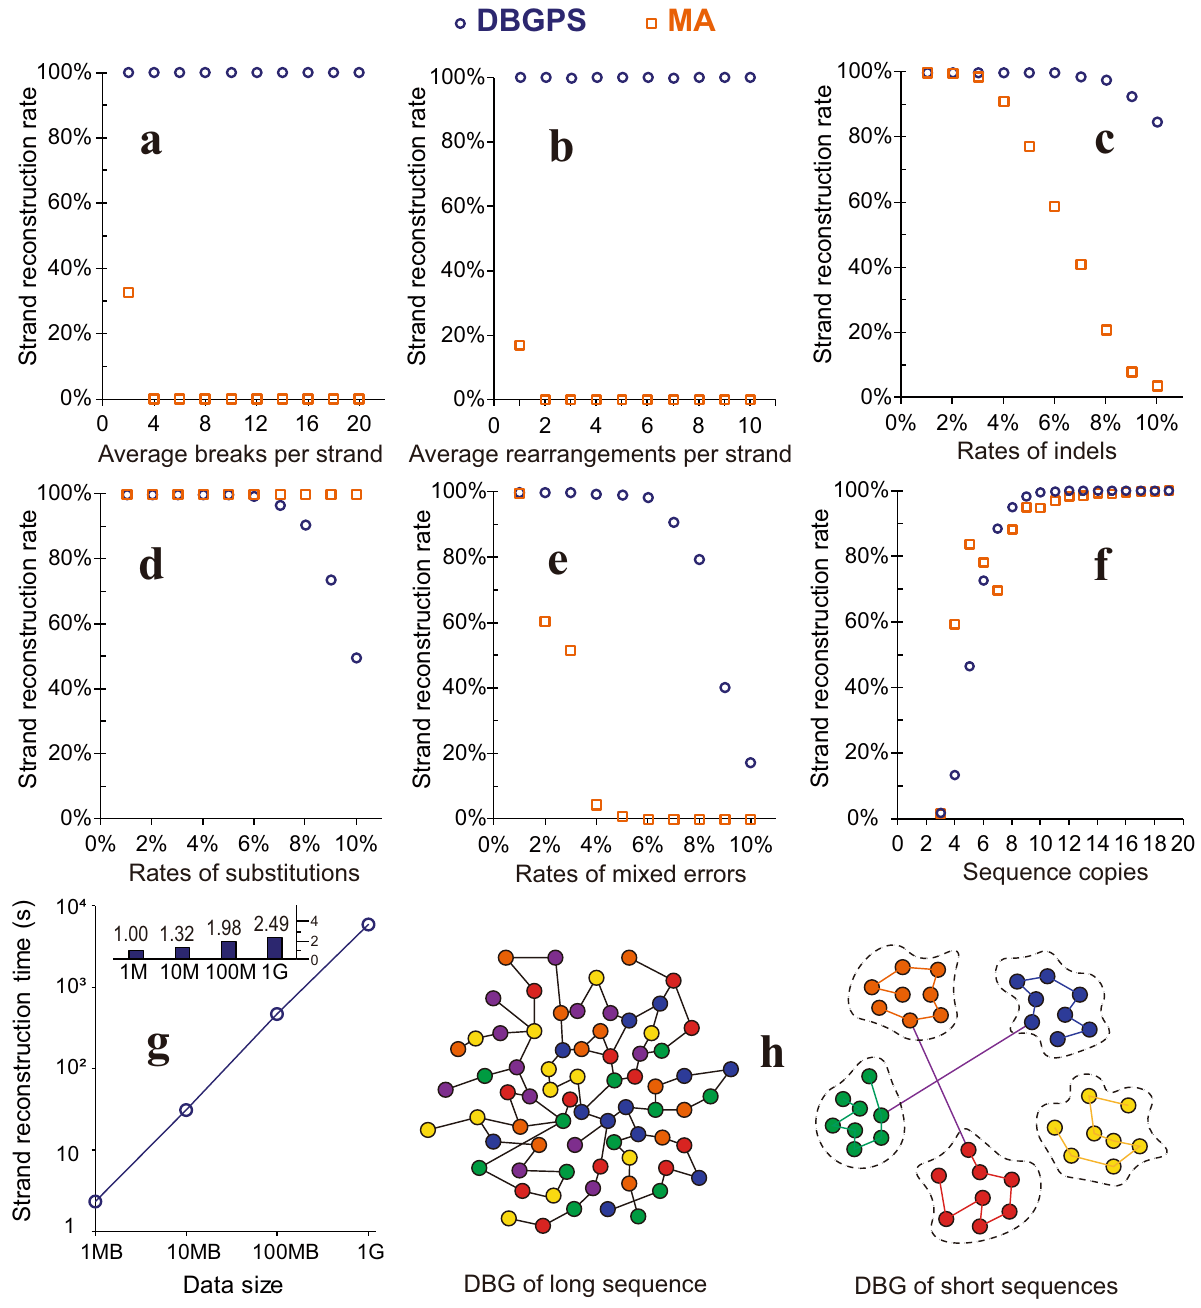
Fig. 2 | Error-handlingcapabilitiesofDBGPS in comparisonwithMAand large- scaleperformancesimulations. Withtwentysequencecopies,theperformanceof DBGPS and MA in handling various rates of ( a ) DNA breaks, ( b ) DNA rearrange- ments, ( c ) indels, ( d ) substitutions, and ( e ) mixed errors. The mixed errors com- priseDNAbreaks,DNArearrangements,substitutions,insertions,anddeletionsina ratioof1:1:2:1:1. f Strandreconstructionrateswithvariousstrandcopiescontaining 3%error mixtures ofsubstitutions (1.5%), insertions (0.75%), and deletions (0.75%). g StrandreconstructiontimebyDBGPSwithdatascalesrangingfrom1MBto1GB.